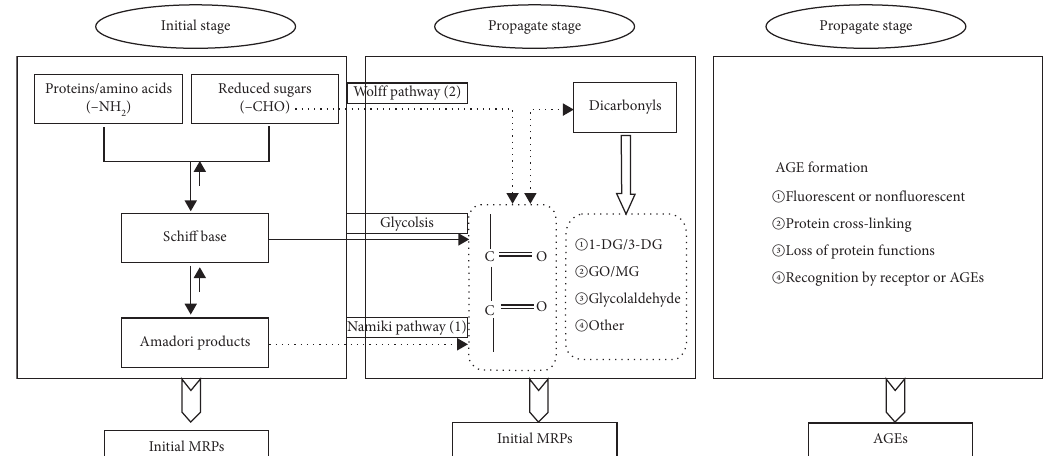
Figure 2: The outlines of the MPRs formation. Schiff bases are produced during reducing glucose-protein reaction. Reactive dicarbonyl precursors of ages are formed through the degradation of Schiff base intermediates (Namiki pathway) or through metal-catalyzed au- toxidation of the reducing sugar (Wolff pathway) [10]. Table 1: The classification, nomenclature, molecular formula, structure, and source of Maillard reaction productions. Classification